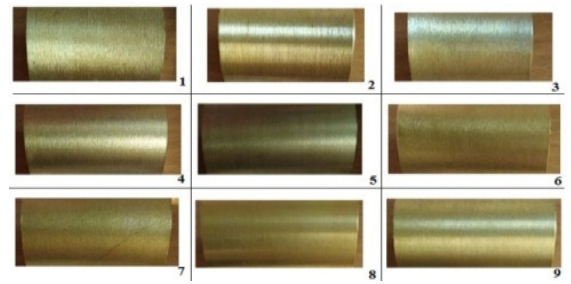
Fig. 1. The work pieces after machining